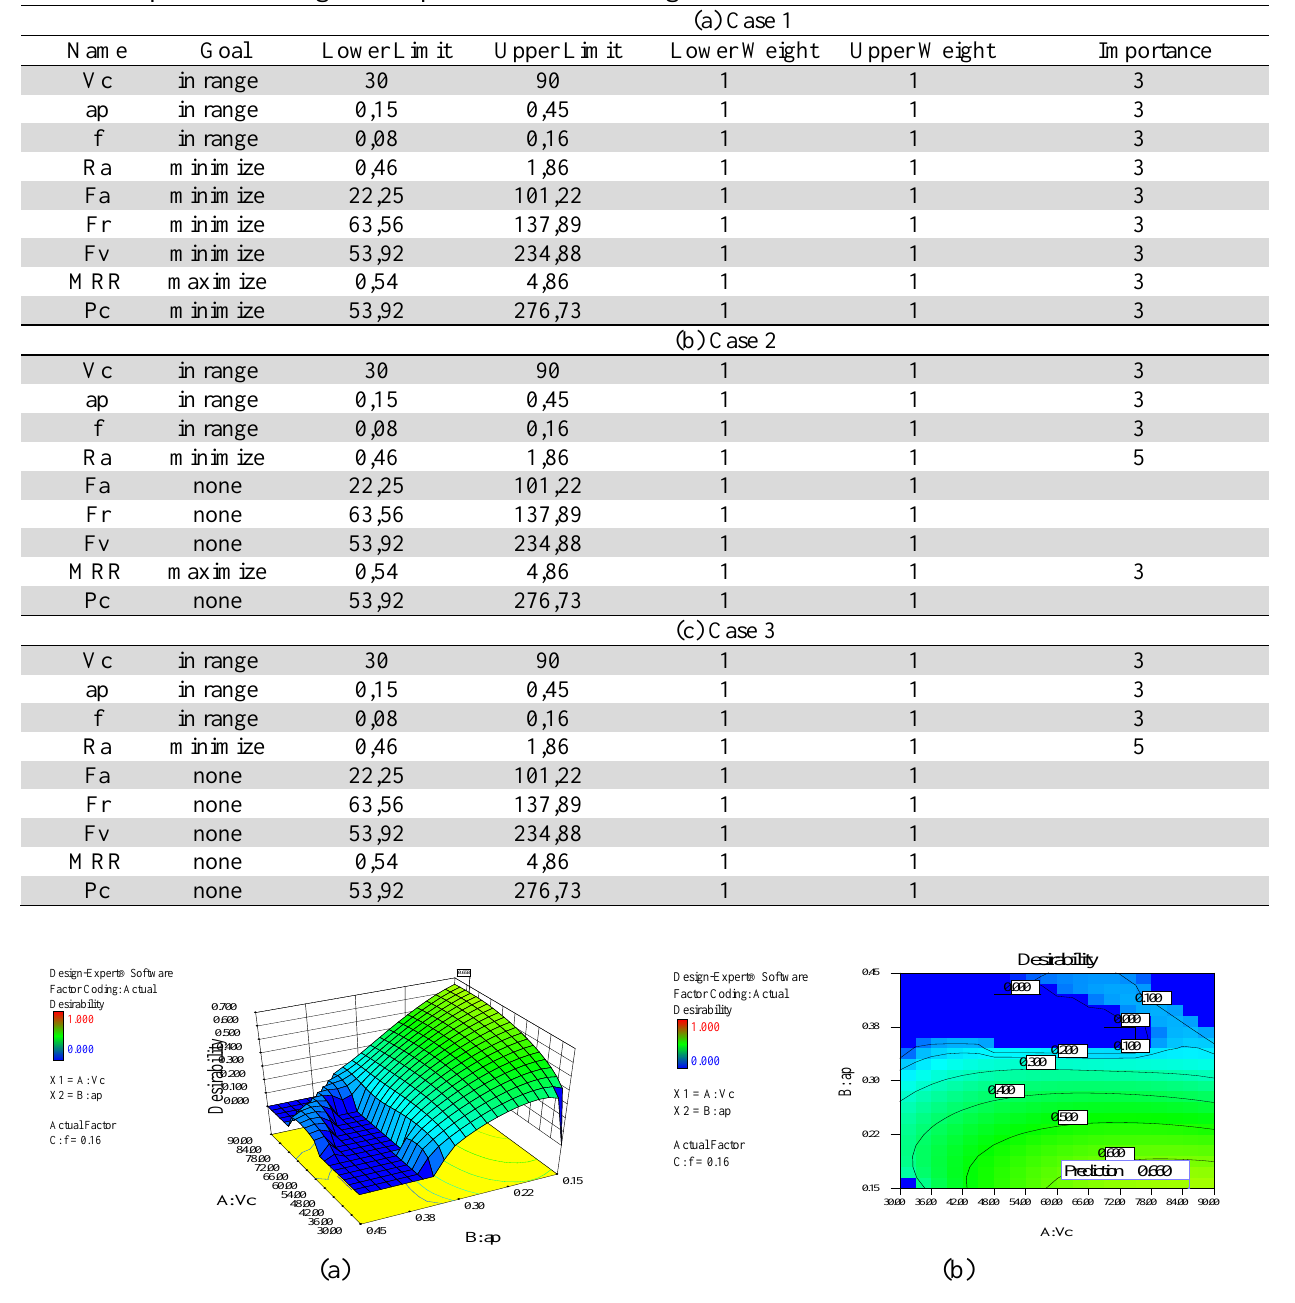
Fig. 19. 3D surface plot (a) and contour plot (b) for Desirability case